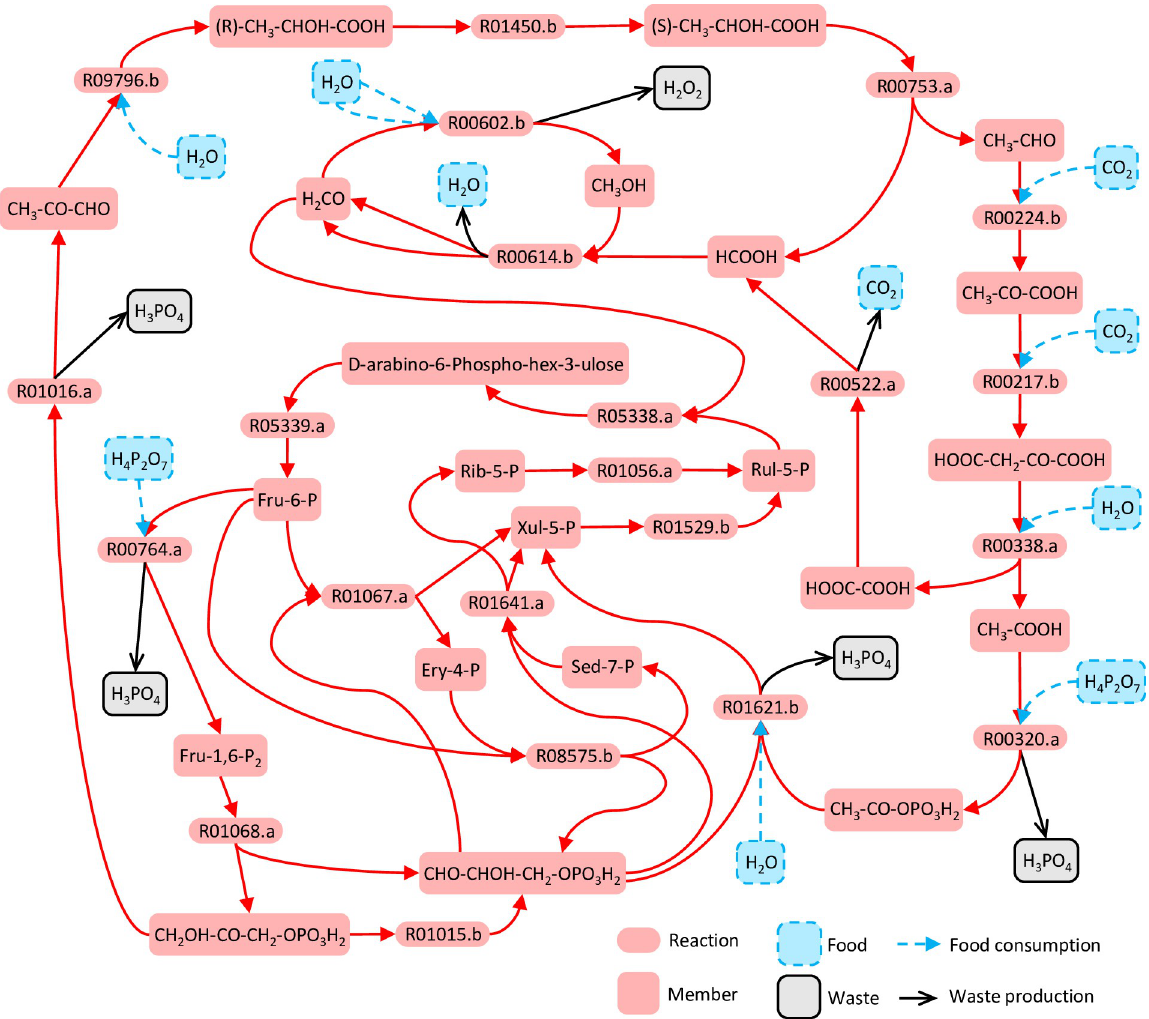
Fig 4. A minimal autocatalytic motif within biochemical tier-1 SDASs. This autocatalytic motif is one of the motifs detected by applying the integer programming procedure to SDAS-bio-1a, with the criterion that the motif should contain as few reaction types as possible. This motif is centered around phosphorylated monosaccharides and small carboxylic